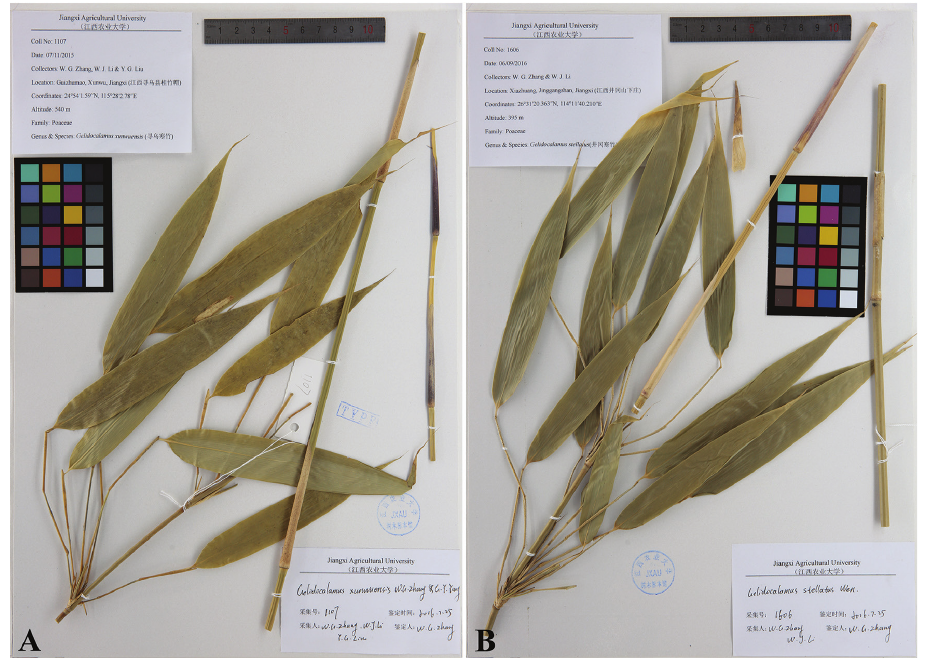
Figure 3. Gelidocalamus xunwuensis and Gelidocalamus stellatus . A G. xunwuensis , China, Jiangxi, Xun- wu County, Guizhumao, W.G. Zhang et al. 1107 (holotype, JXAU!), with culm leaf sheath stiffly hairy and foliage leaf broadly lanceolate to narrowly oblong B G. stellatus , China, Jiangxi, Jinggangshan, Xi- azhuang, W.G. Zhang & W.J. Li 1606 (JXAU!), with culm leaf sheath glabrous and foliage leaf lanceolate to narrowly